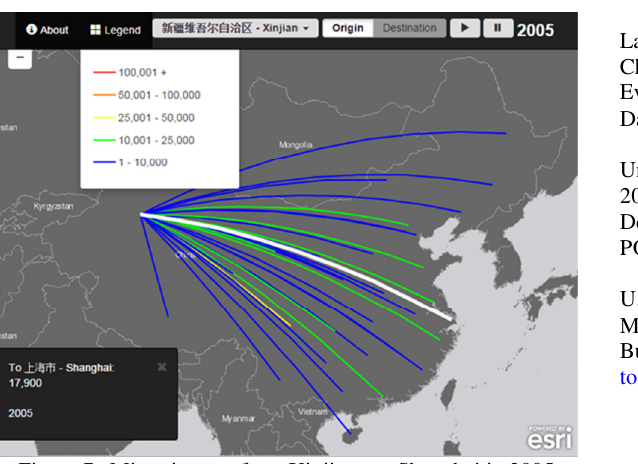
Figure 7a Migration out from Xinjiang to Shanghai in 2005